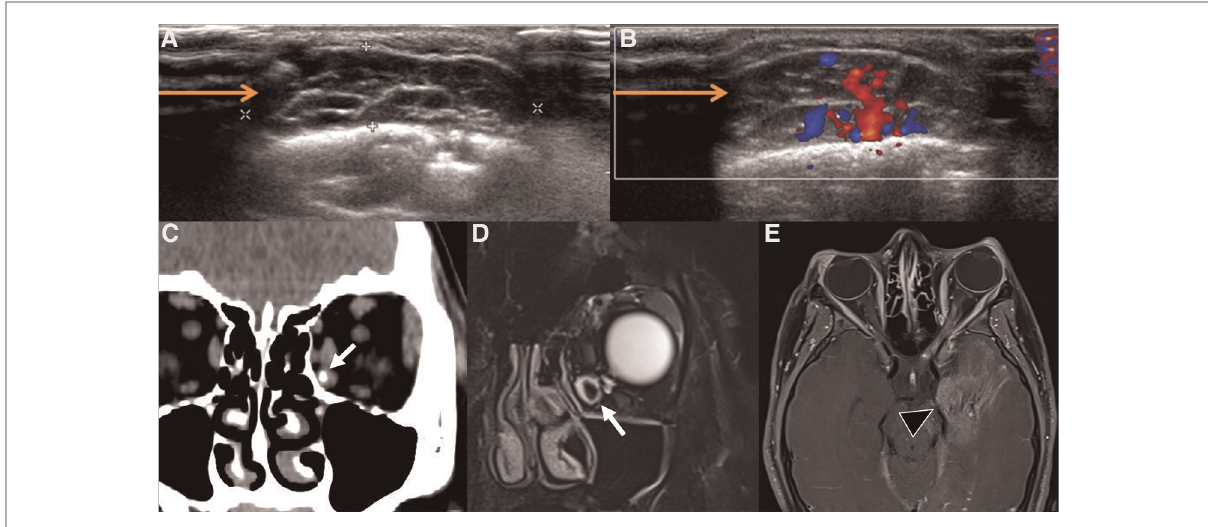
FIGURE 9 Imaging of venous malformations. ( A,B ) US of a venous malformation of the lid in a 7-year-old boy. B-mode US ( A ) shows a compressible, relatively well-marginated mass with a “ spongiform appearance ” consisting of multiple anechoic dilated venous spaces separated by hyperechoic septa; on color Doppler US during Valsalva maneuver ( B ) a slight increase in size and increased representation of color-Doppler signal (baseline not shown) can be appreciated. ( C – E ) Coronal CT ( C ), coronal fat-suppressed T2-weighted image ( D ) and axial post-contrast fat-suppressed T1- weighted images ( E ) of a venous malformation of the orbit in a 13-year-old girl. A phlebolith within dilated venous channels is clearly evident at CT and MRI (target sign, white arrows in C,D ); axial post-contrast FS T1 weighted image also shows an associated diffuse hemispheric venous drainage anomaly (black arrowhead in E